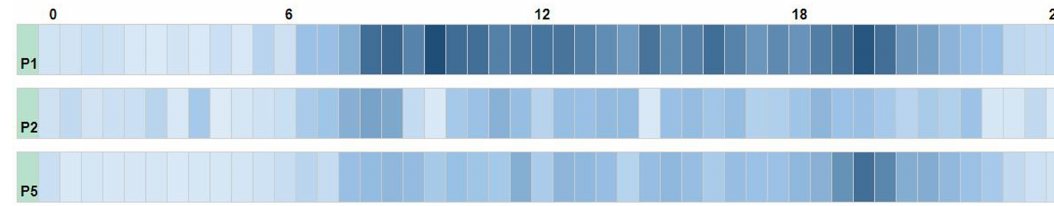
Figure 3. Average number of steps of the three more active participants during the